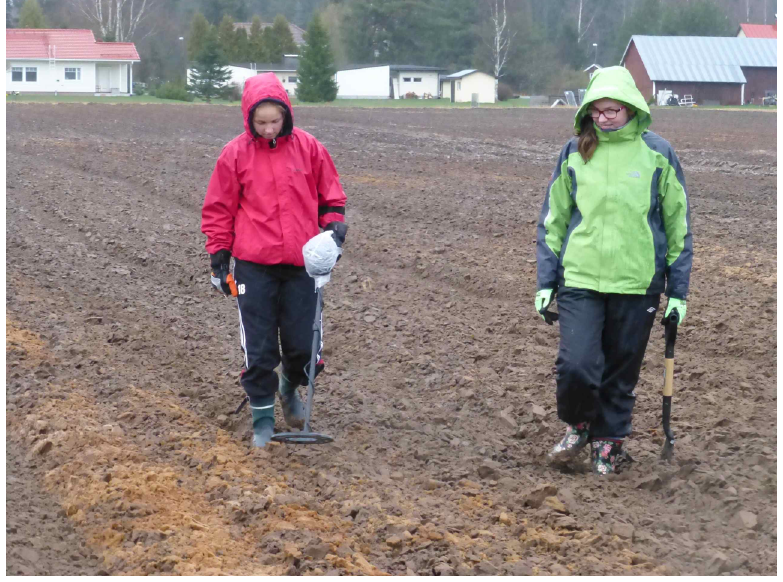
Fig. 2. Students from Ulvila testing a metal detector in practice. Photograph by Leena Koivisto, Satakunta Museum. The main challenges around metal detecting in the Satakunta region are the lack of time and staff resources both in the Satakunta Museum and in the NBA. Detectorists get frustrated, as it takes months to receive information about their finds, not to mention the possible redemption fees from the NBA. In addition, the museum archaeologist finds one particular aspect of the engagements distressing, in that there are no possibilities to do full survey work on all the new find locations in the region that the detectorists report. At the same time, the archaeologist is expected to make a quick decision whether or not the reported find spot indicates a site that under law should be protected. Such a decision would end detecting but also have effects on many other possible land use plans that the landowner might